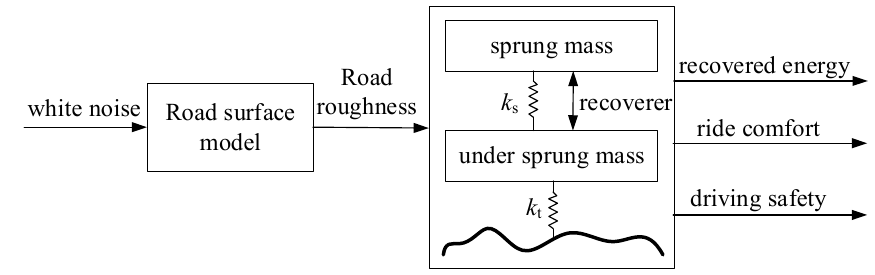
Figure 5. Vehicle–pavement-suspension energy recovery system model.